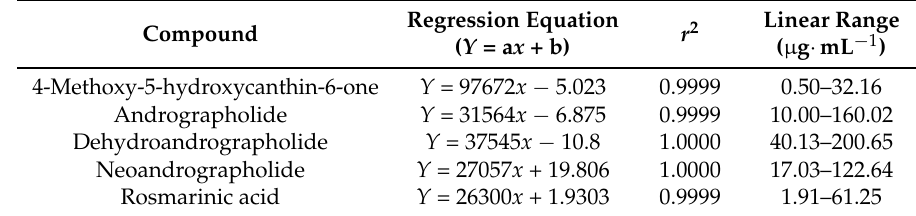
Table 4. Calibration curves for the analysis of the five bioactive